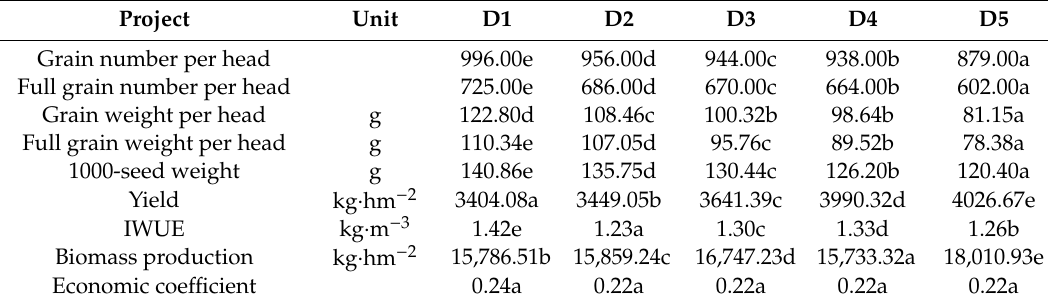
Table 8. Yield attributes in 2016.